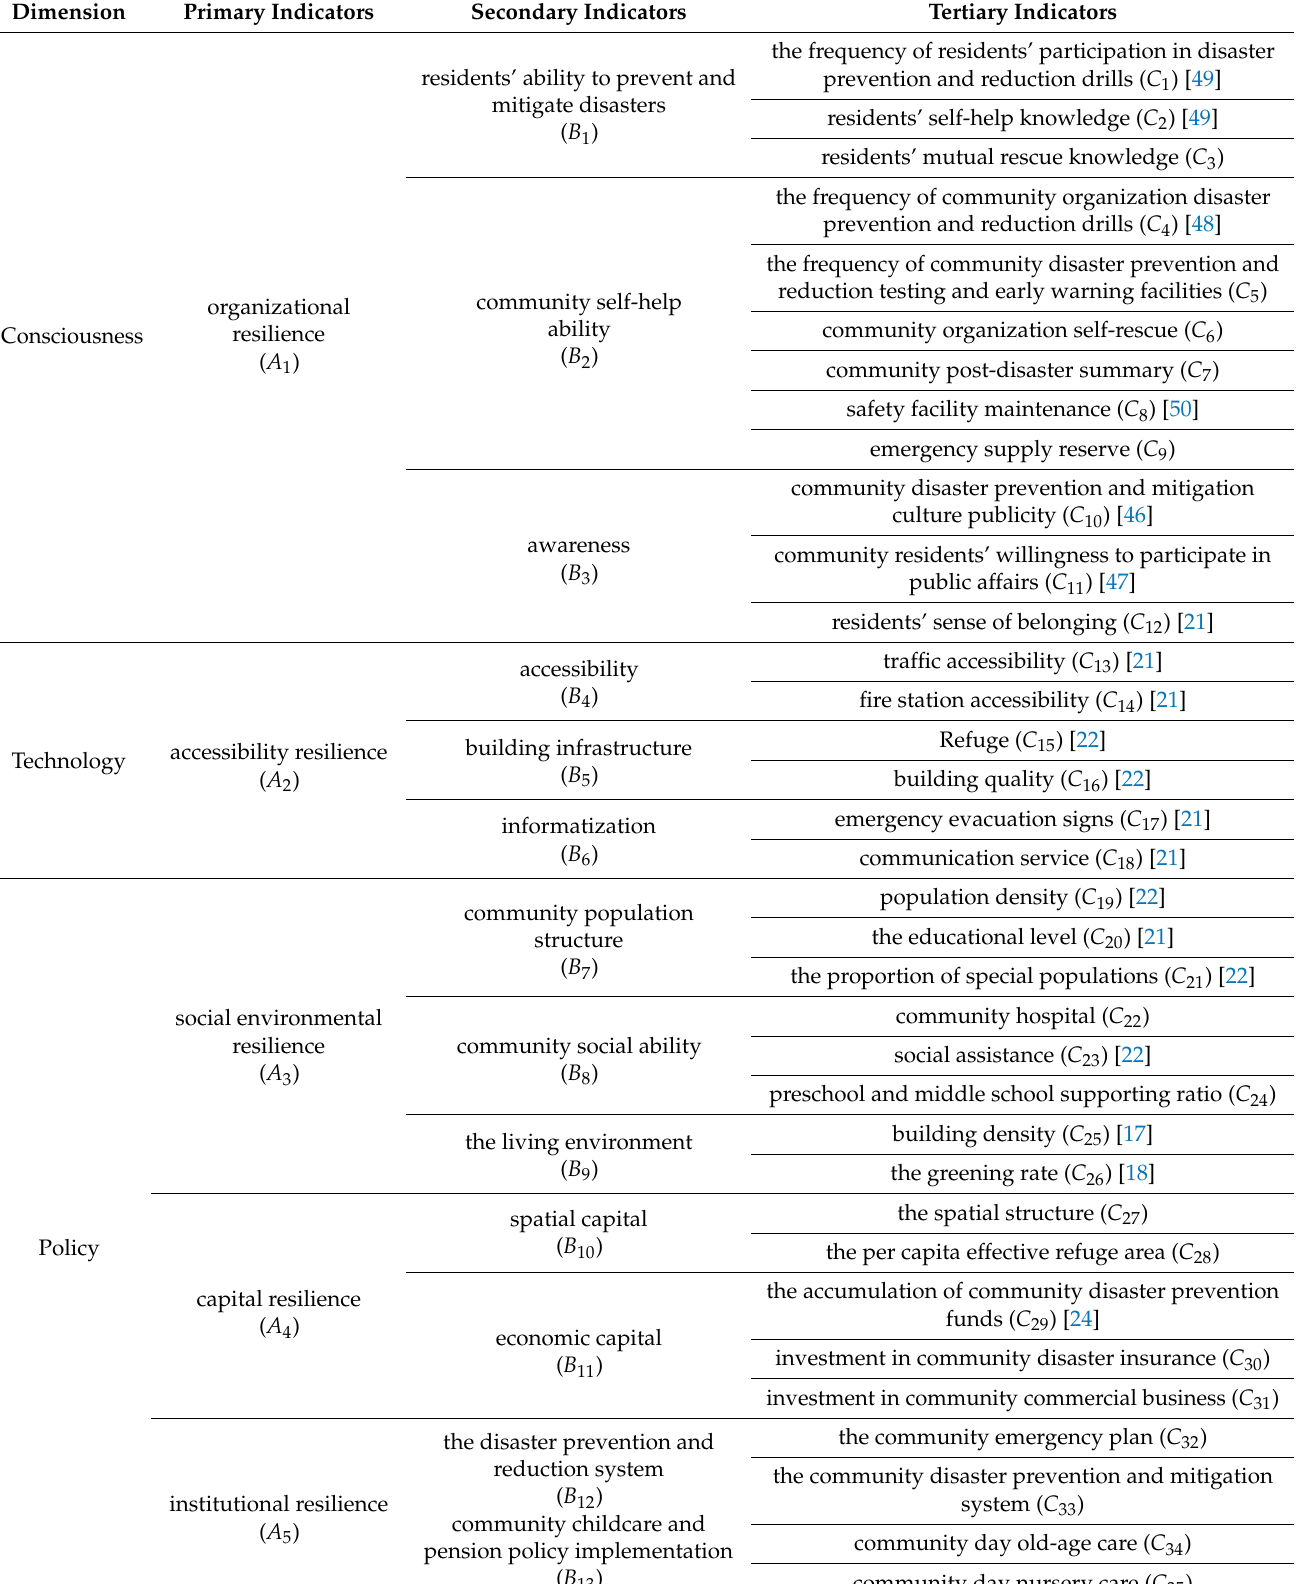
Table 2. Initial indicators of a safe